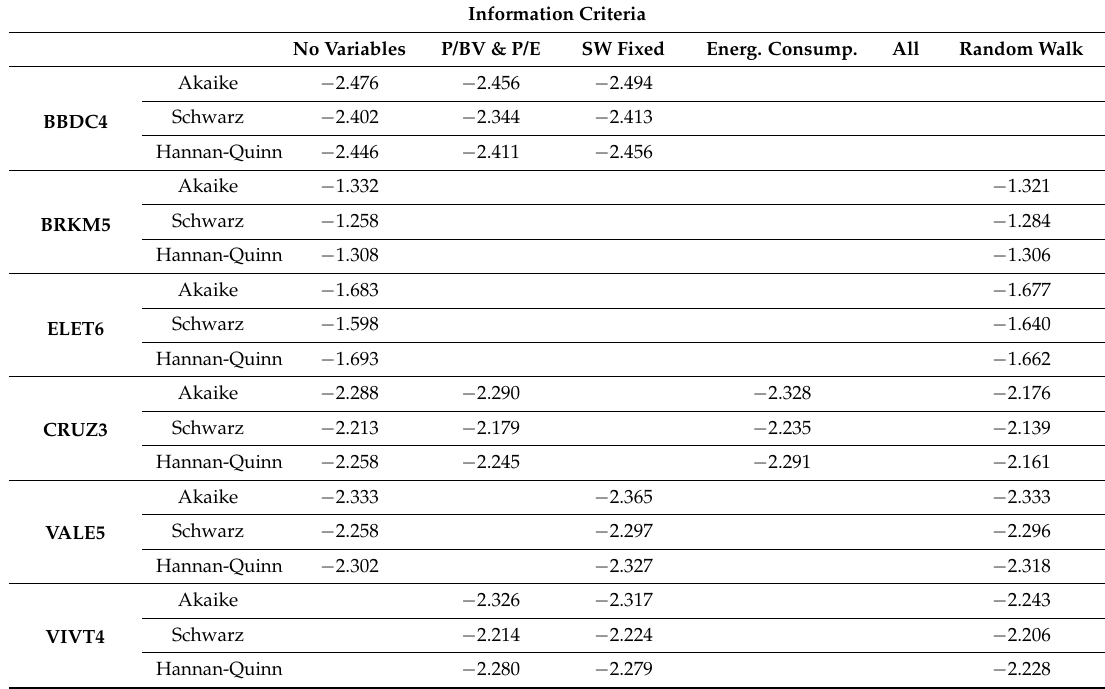
Table A9. Information